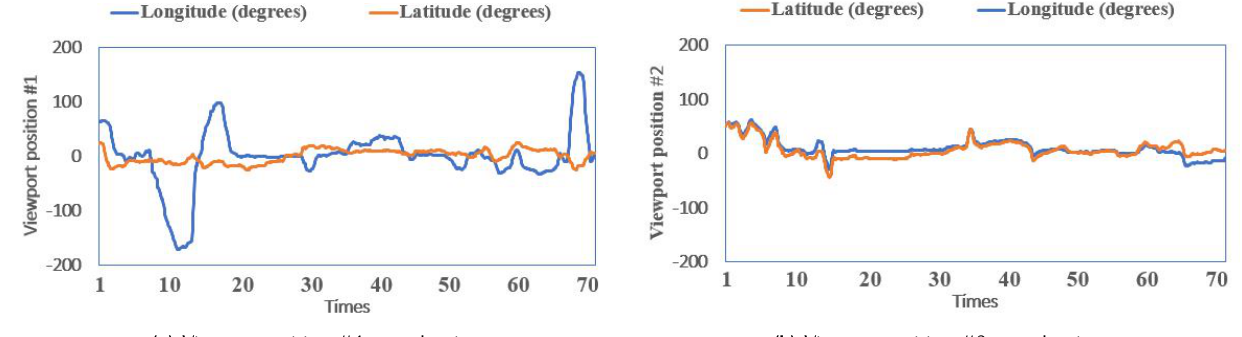
Figure 6. Viewport position #1, and #2 over the time to 95%. GRU is less accurate than LAST and LINEAR from the first second and greater than of LAST and LINEAR in the next three seconds. It can be explained that because the GRU algorithm takes the first amount of time to process the data, there is no high accuracy in the first seconds. But from the next seconds, the GRU gives good results.